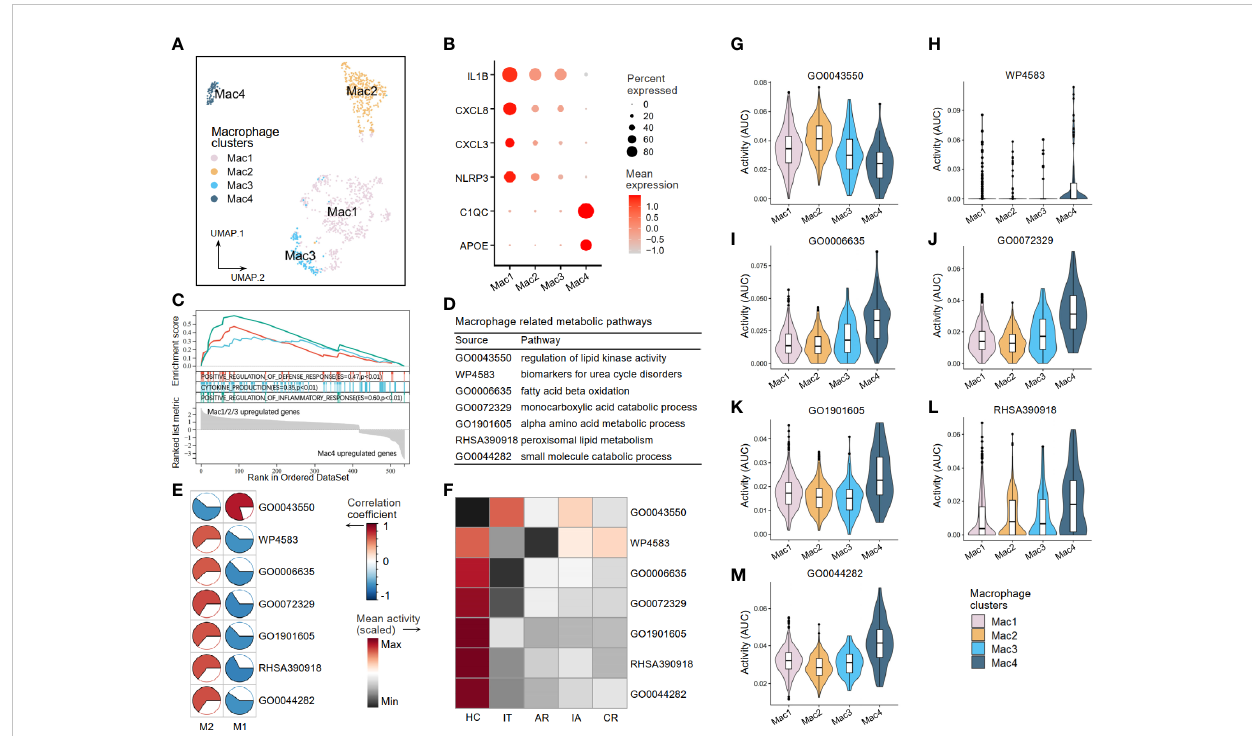
FIGURE 8 The metabolic perturbations of macrophage clusters in hepatitis. (A) UMAP visualization of the macrophage clusters. (B) Dot plot showing the expression levels of given genes in each cluster. (C) GSEA of the signi fi cant DEGs between Mac1 – 3 and Mac4. An enrichment score (ES)>0 indicated that the pathway is upregulated in Mac1 – 3, while an ES < 0 indicated that the pathway is upregulated in Mac4. (D) Macrophage-related metabolic pathways and corresponding database sources. (E) Heatmap showing Pearson ’ s correlation coef fi cients between the activities of metabolic pathways and the Macrophage in fi ltration fractions. (F) Heatmap showing the scaled mean activities of metabolic pathways in each group. HC, healthy control; IT, immune tolerant phase; AR, acute recovery phase; IA, immune active phase; CR, chronic resolved phase. (G – M) The activities of metabolic pathways in each macrophage cluster. UMAP, Uniform Manifold Approximation and Projection; GSEA, gene set enrichment analysis; DEGs, differentially expressed